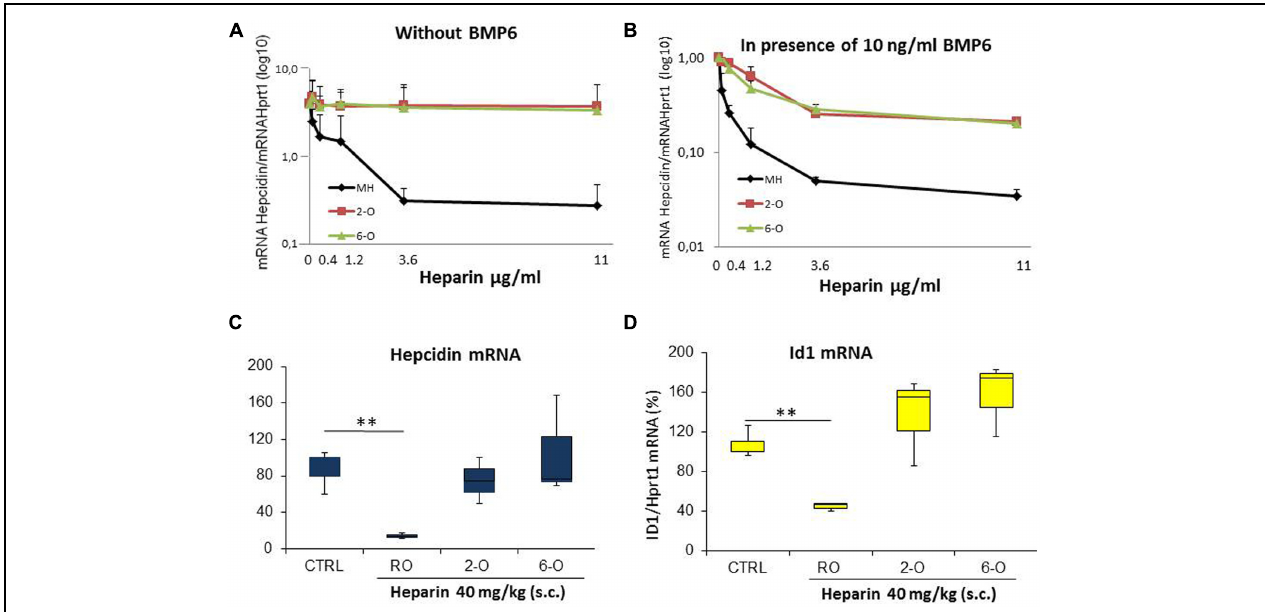
FIGURE 2 | Analysis of 2-O and 6-O desulfated mucosal heparins. The unfractionated and unmodified Mucosal Heparin (MH) and of the two desulfated preparations (2-O and 6-O) were added to HepG2 at different concentrations (0.12-0.4-1.2-3.6-11 µ g/ml) for 6 h without (A) or in presence (B) of BMP6 (10 ng/ml). The level of hepcidin mRNA was evaluated by qRT-PCR after 6 h of treatment and normalized for Hprt1. Three independent experiments for (A,B) were performed and the mean values expressed in logarithmic scale vs. untreated cells (value 1) were reported in the graphs. (C,D) The heparins (RO-82, 2-O and 6-O) were injected subcutaneously in the mice at the concentration of 40 mg/Kg. The mice were sacrificed after 6 h and the liver hepcidin and Id1 mRNA quantified by qRT-PCR. The values were normalized for Hprt1 and reported in a box plot as a percentage of saline treated mice (CRTL). Id1 was a control of the activation of the BMP/SMAD pathway. ∗∗ is a P -value < 0.001.